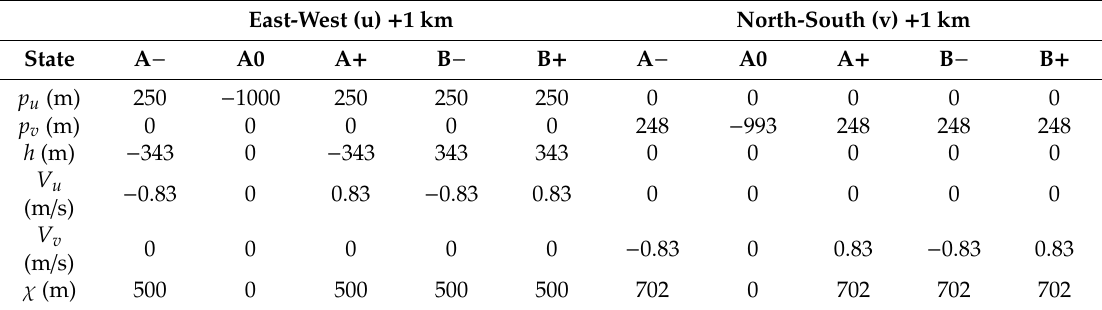
Table 5. Sensitivities of individual states are shown to + 1 km displacements applied individually to each of the five input scenes at the midpoint between GOES-16 and -17 on the